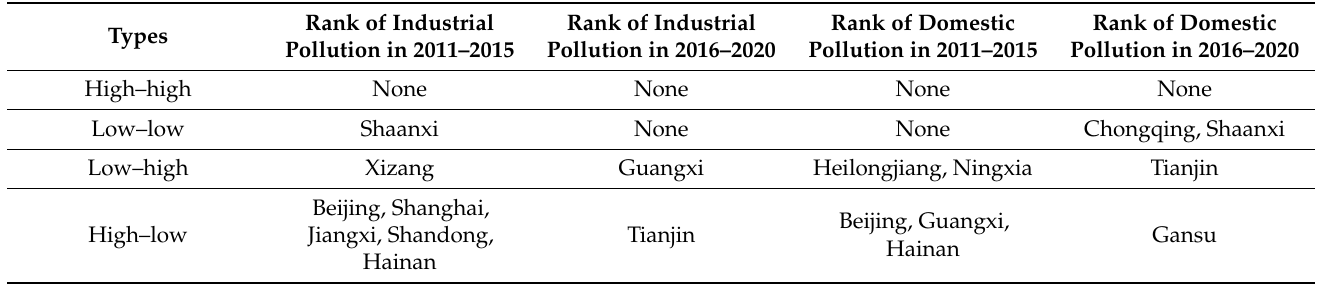
Table 5. Local Moran’s I of ranks in administrative